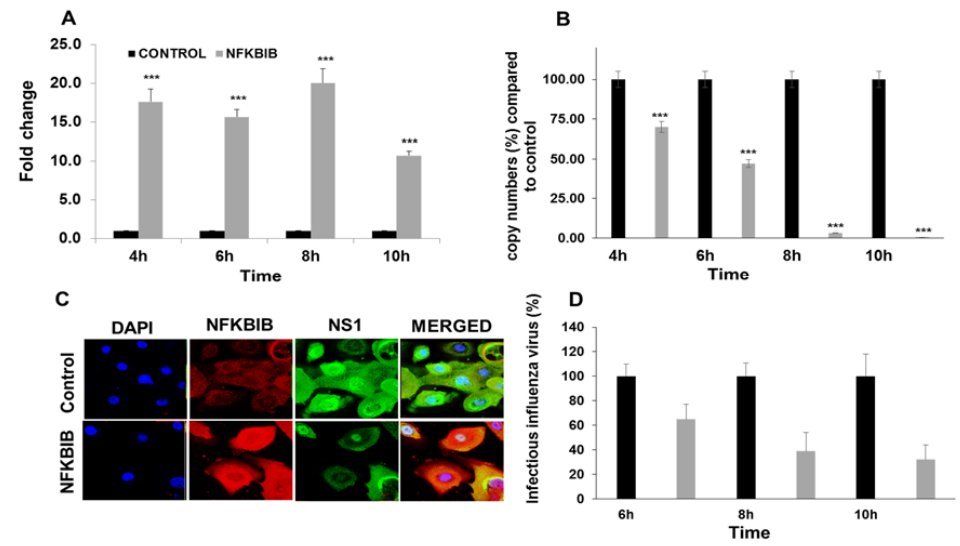
Figure 7. NFKBIB overexpression leads to reduction in IAV M gene copy number. ( A ) HBEpCs grown to 80% confluency were transfected with NFKBIB plasmid or control plasmid for 36–48 h. NFKBIB overexpressing HBEpCs were infected with 1 MOI of IAV for another 10 h, and the expression of NFKBIB was analyzed using RT ‐ PCR. *** p < 0.001 ( n = 3); ( B ) NFKBIB overexpressing HBEpCs were infected with 1 MOI of IAV for another for 10 h, and the IAV matrix gene copy numbers were analyzed using the matrix gene primers, and a standard curve for the matrix gene. *** p < 0.001 (Black—Control plasmid, Grey—NFKBIB gene overexpressing); ( C ) HBEpCs overexpressing NFKBIB gene were cultured on slides and infected with IAV of 1 MOI. Cells were then fixed and stained with NFKBIB (red) and NS1 (influenza) antibodies (green), followed by respective fluorescent secondary